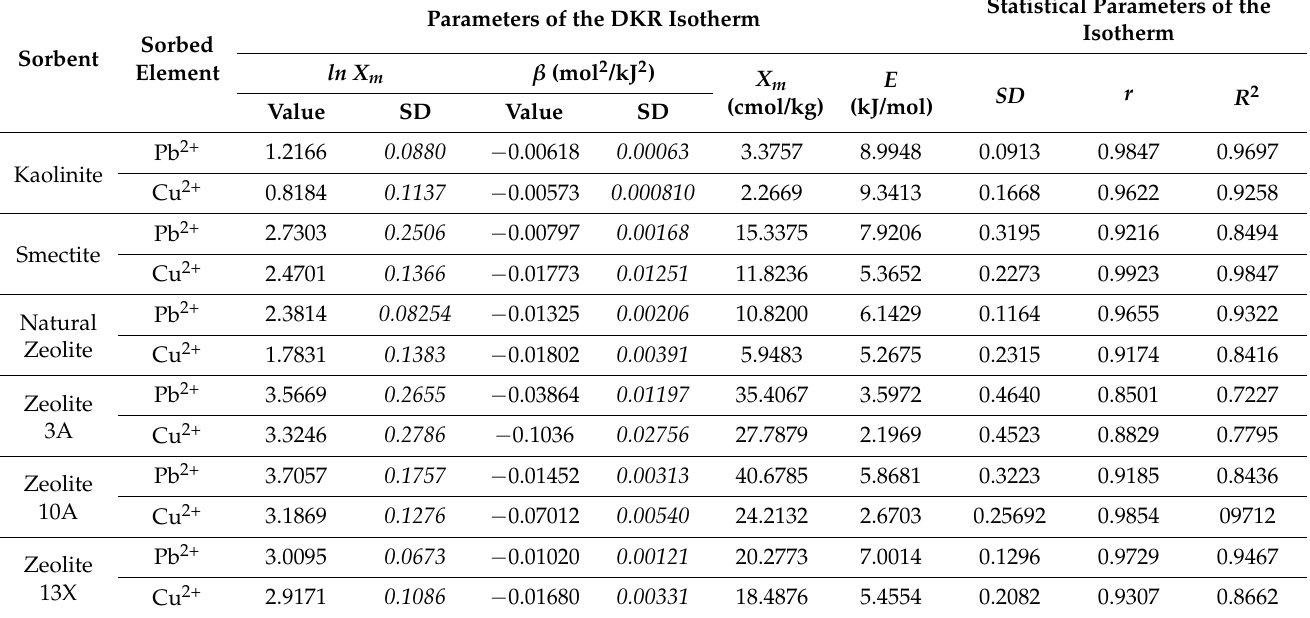
Table 6. Parameters of the DKR isotherms and isotherms’ statistical